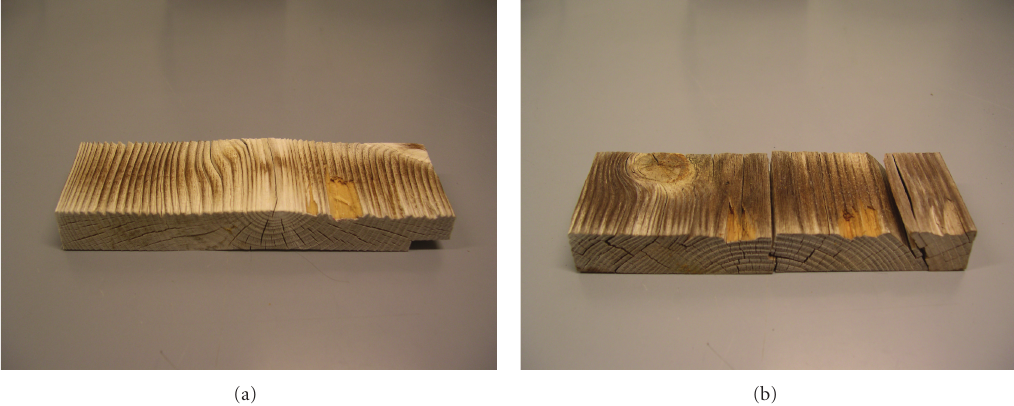
Figure 1: Wood sample A (a) and wood sample H (b) after 115 days of accelerated ageing in the Atlas Solar Simulator climate chamber. Direct solar radiation exposed side shown upwards. Small wood pieces are cut from the samples for use in the FTIR